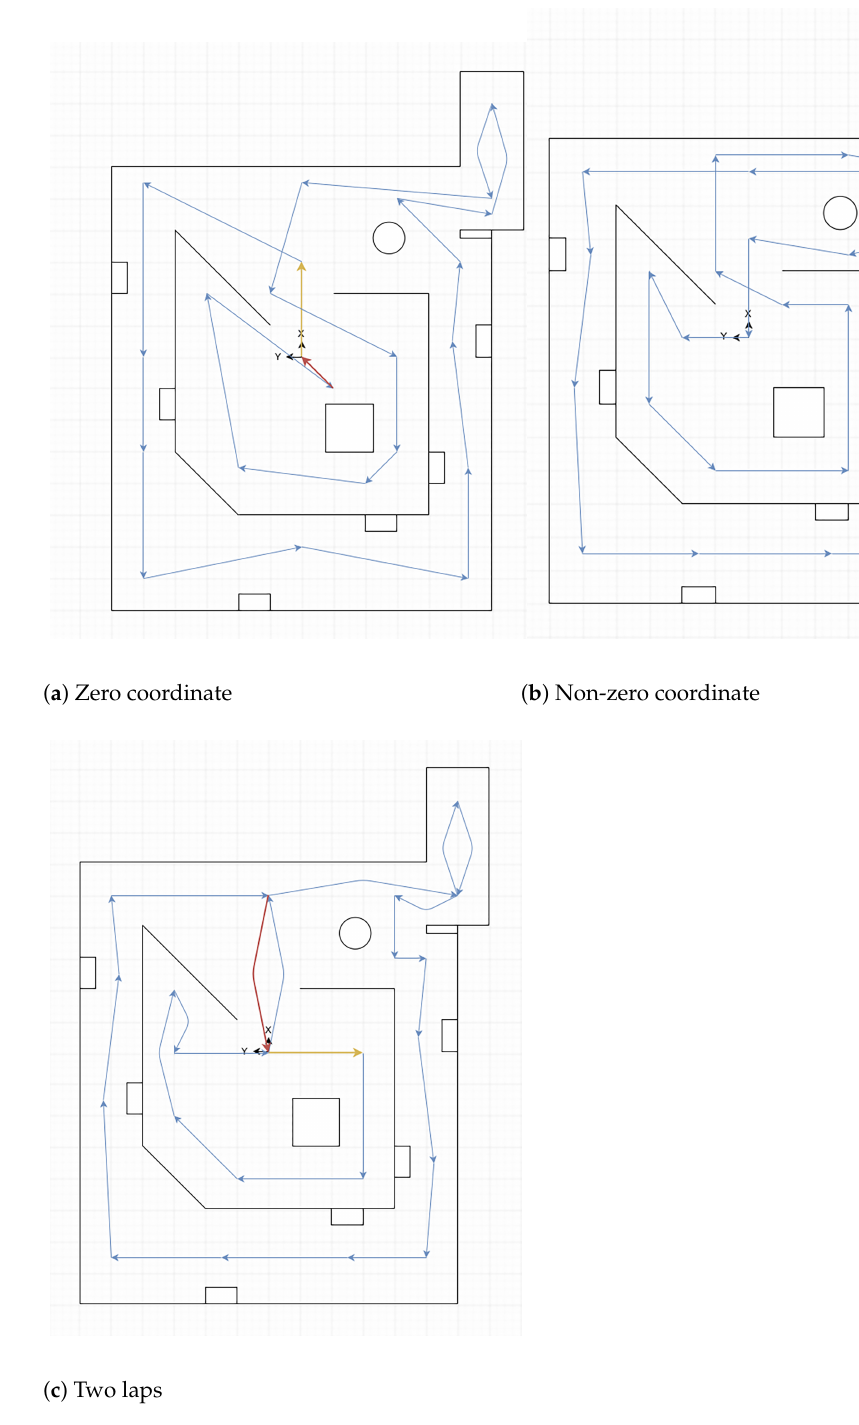
Figure 4. Training arena